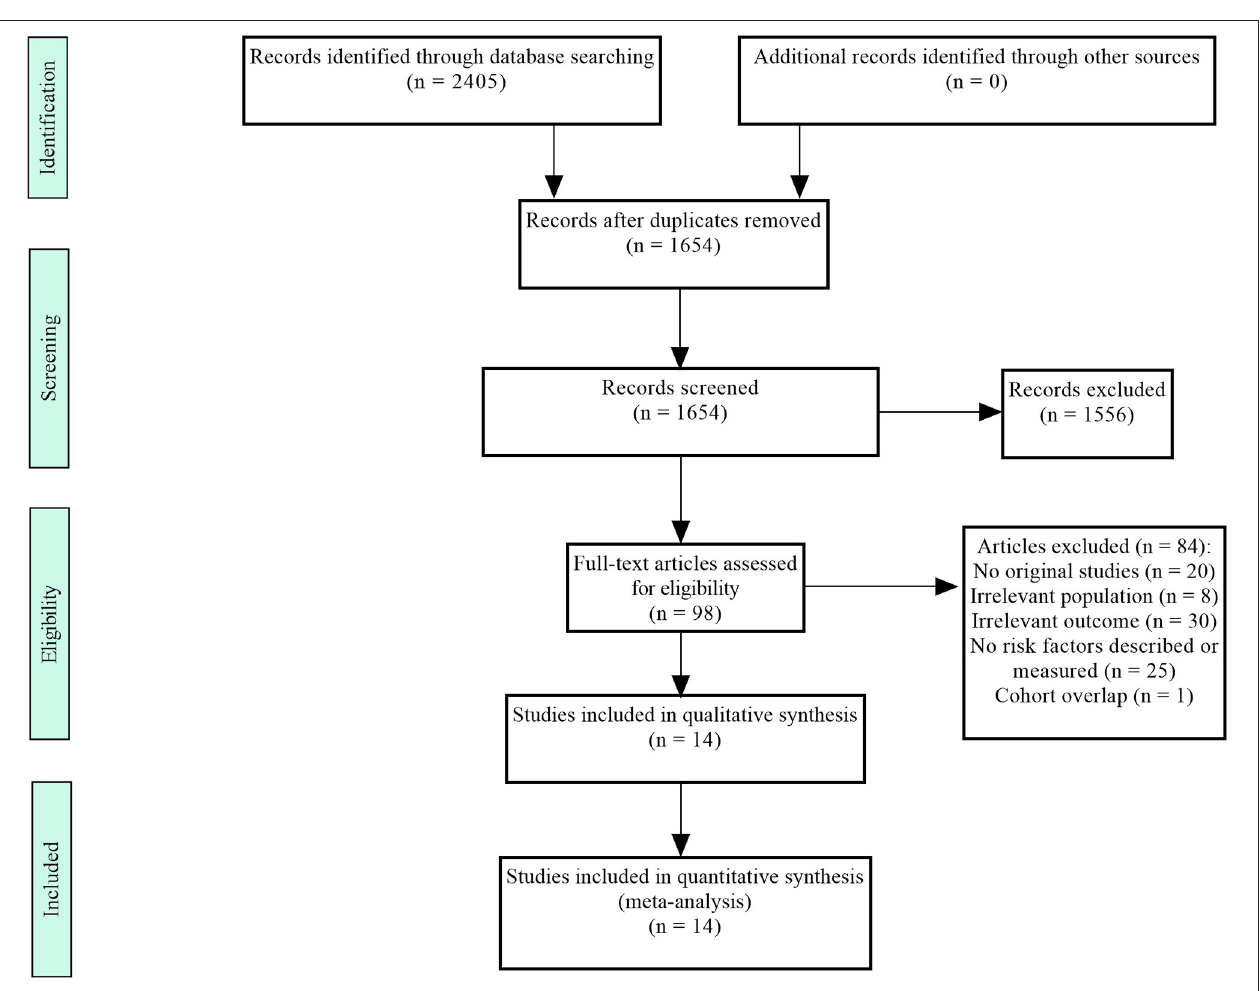
FIGURE 1 | Flowchart of the selection